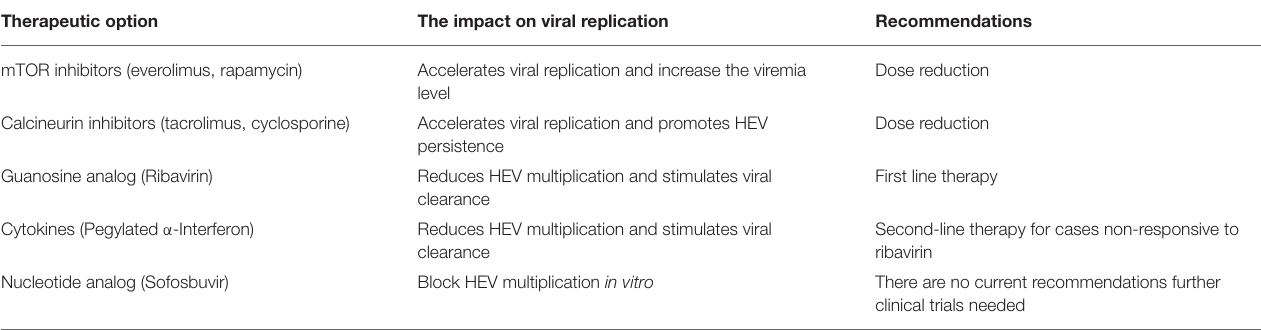
TABLE 6 | Treatment recommendations proposed for chronic HEV patients after solid organ transplantation. Therapeutic